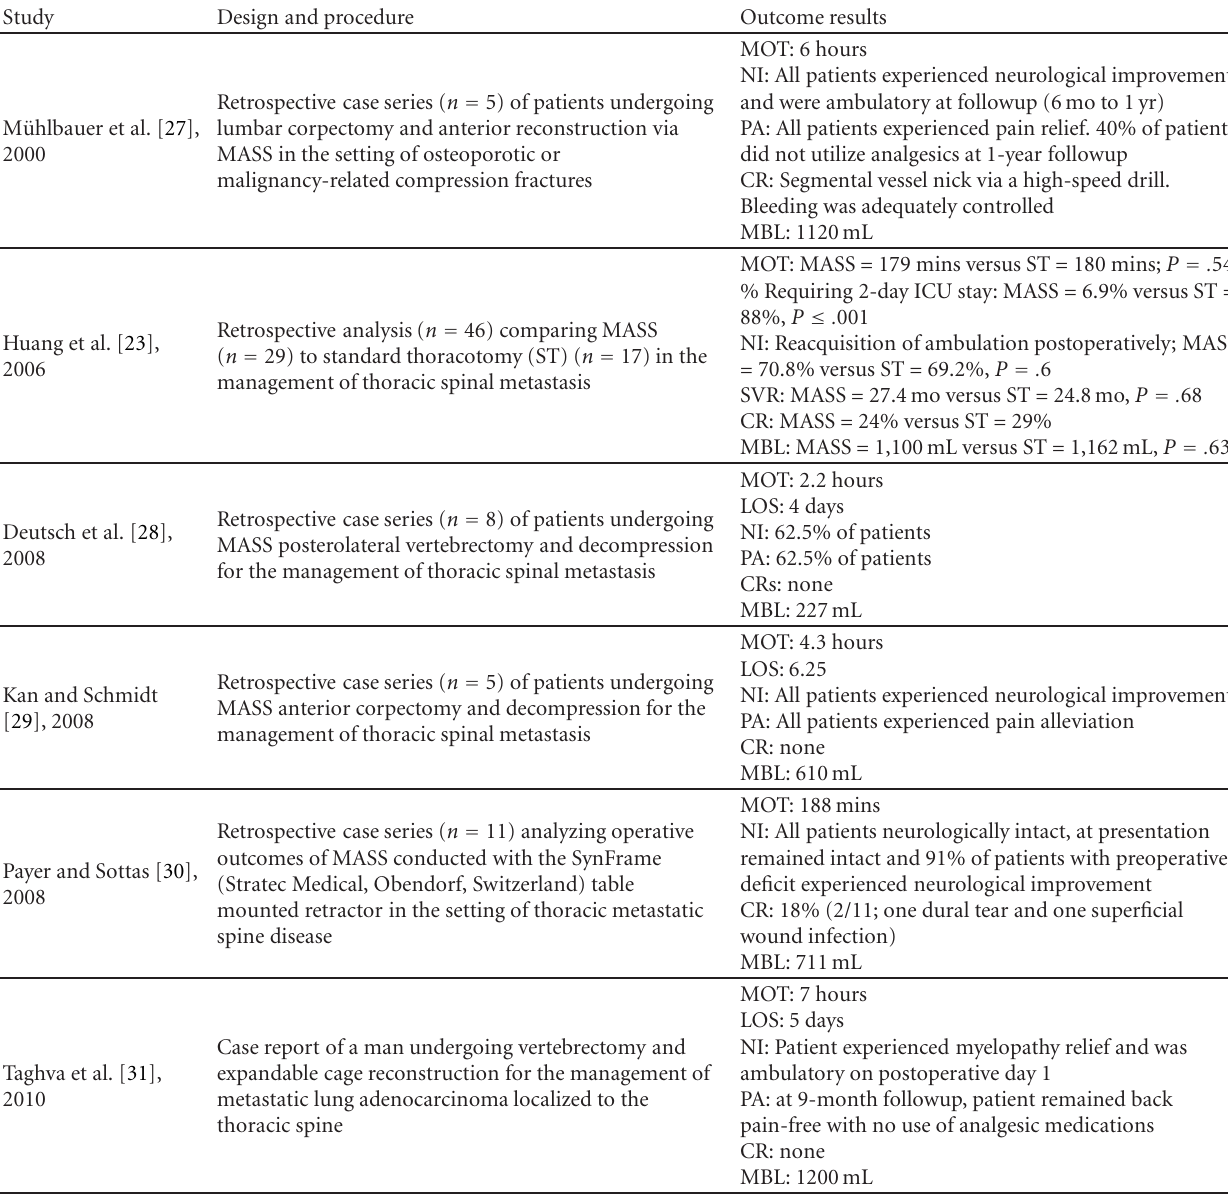
Table 2: Minimal access spine surgery outcomes. MOT: Mean operating time; LOS: Length of stay; NI: Neurological improvement rate; PA: Pain alleviation rate; CR: Complications rate; MBL: Mean blood loss, SVR: 2-year survival